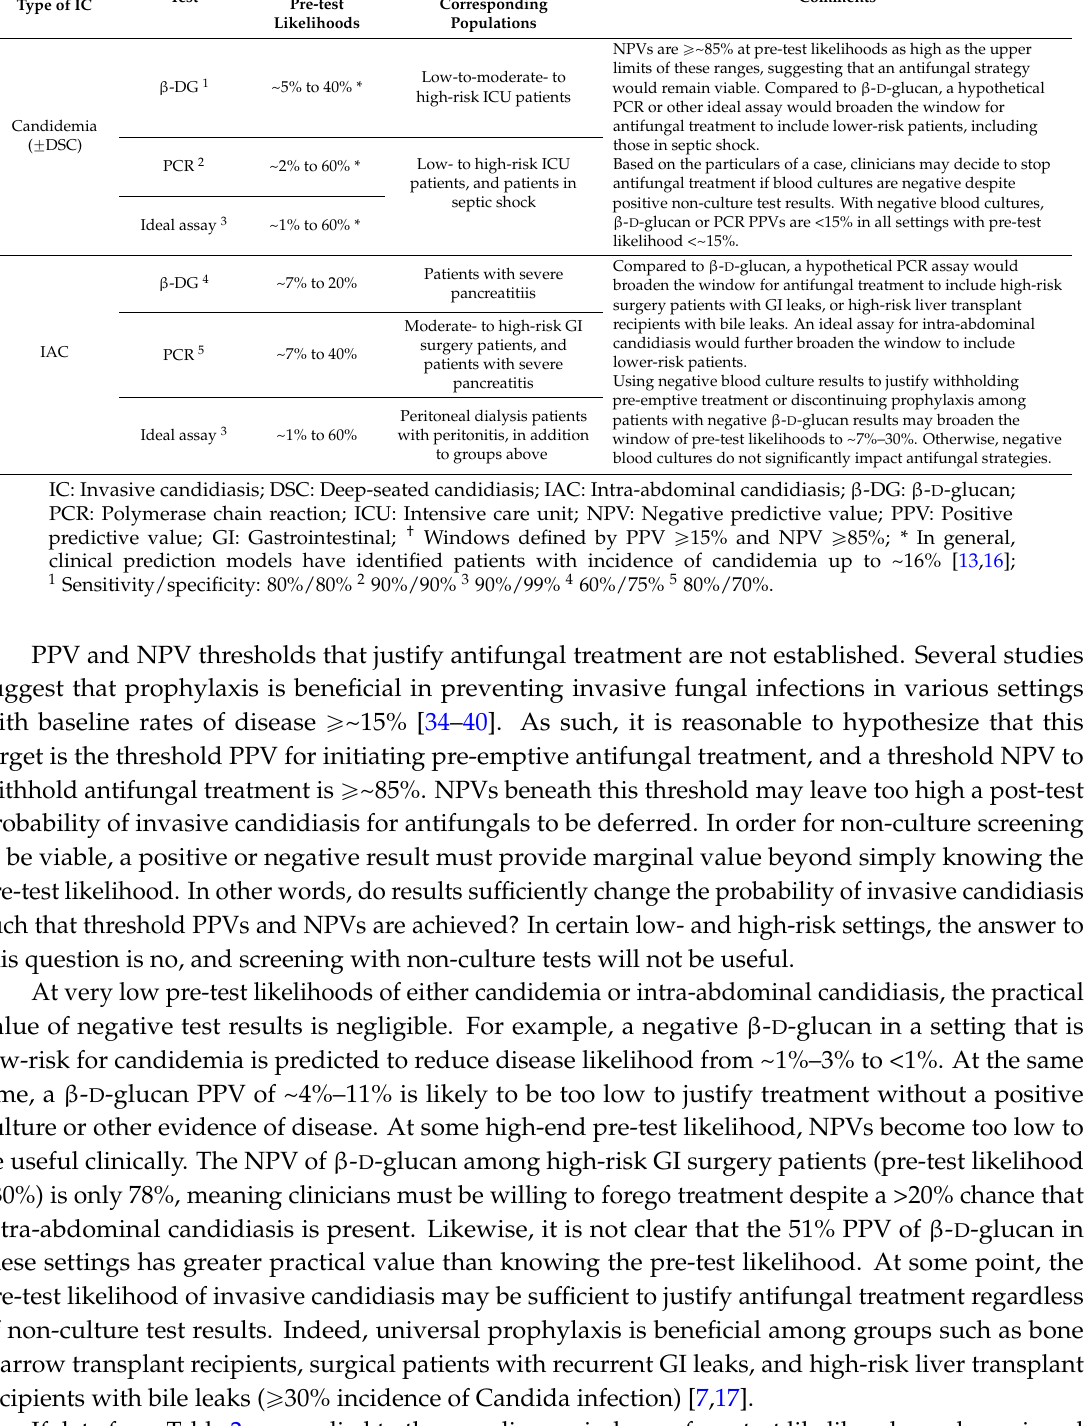
Table 3. Windows in which non-culture tests are predicted to be useful in guiding antifungal treatment. Predominant Type of IC Test